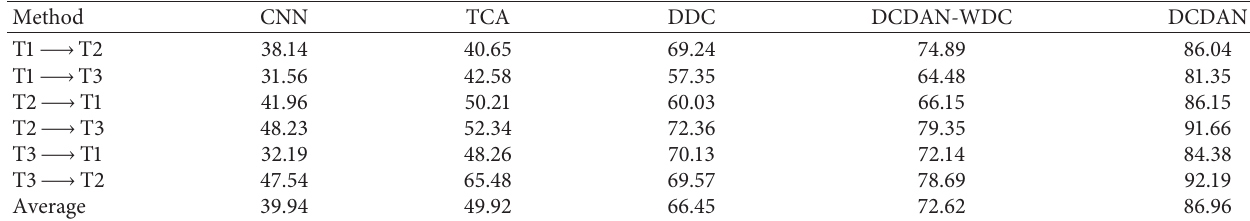
Table 5: Experimental result of bearing test rig.